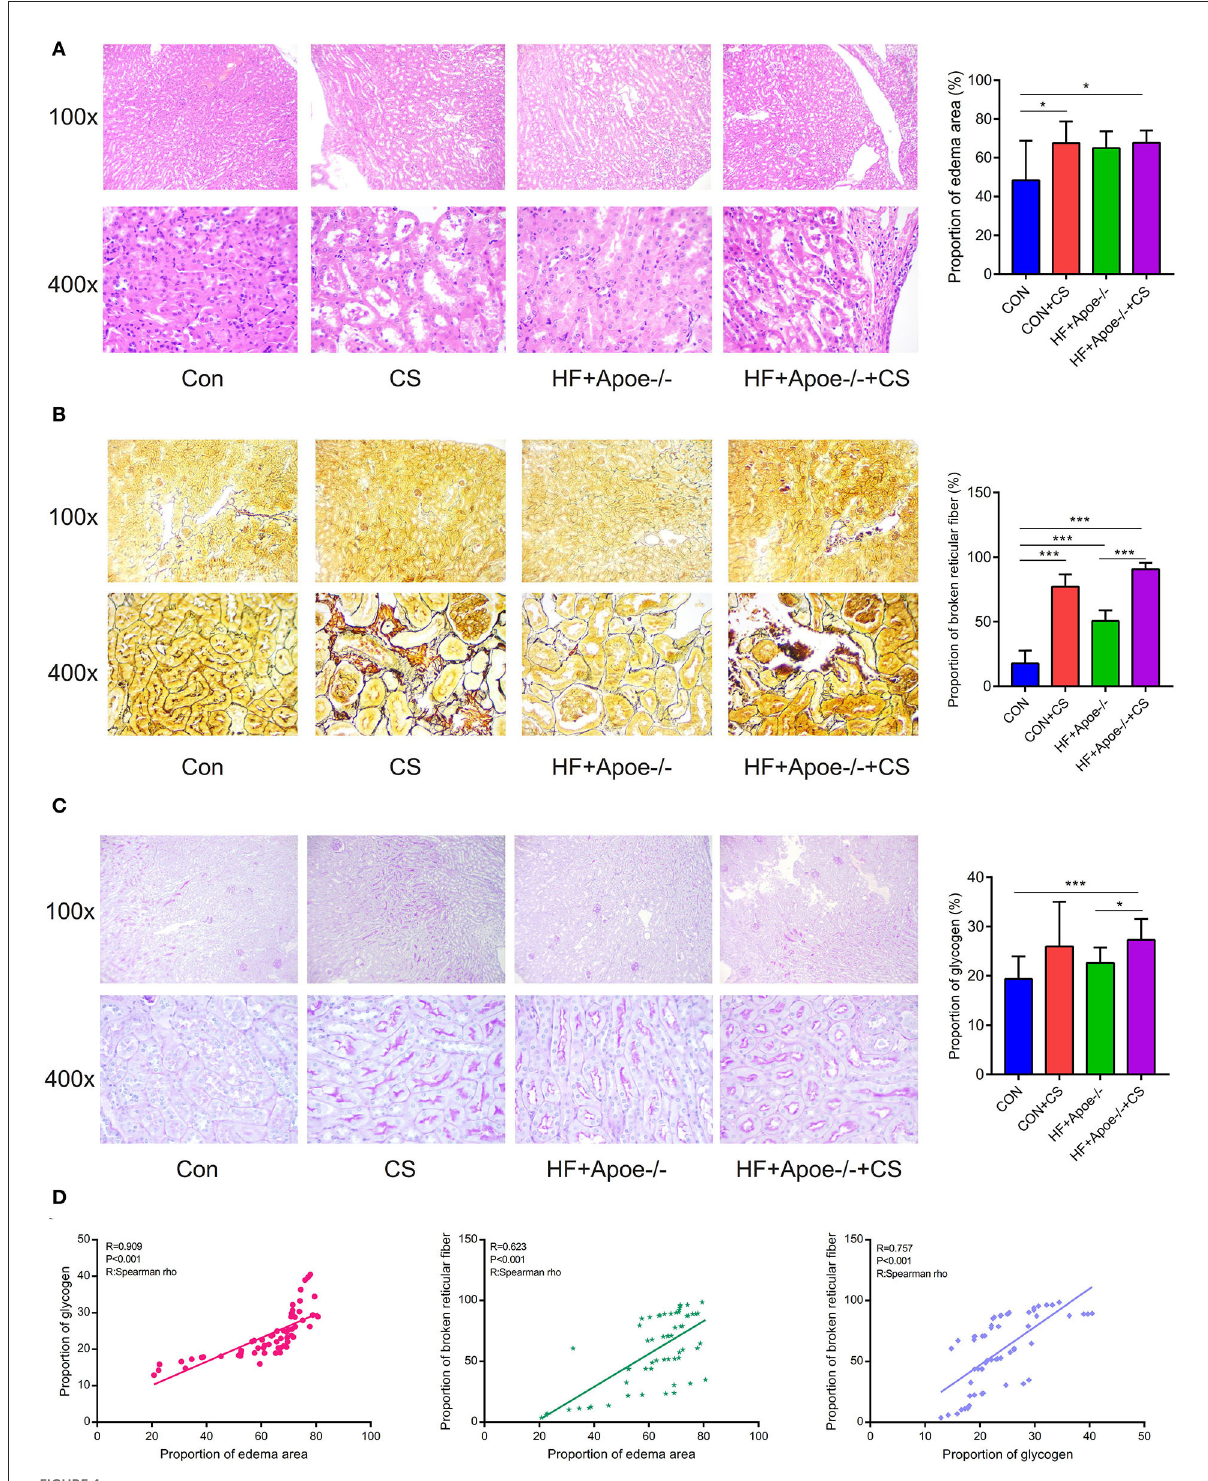
FIGURE4 Edema, broken reticular fibers, and increased glycogen in the kidney under in the HF + Apoe − / − + CS group. (A) HE staining manifested that there existed edema in the kidney at different degrees in the CS, HF + Apoe − / − , and HF + Apoe − / − + CS groups. (B) In the CS, HF + Apoe − / − , and HF + Apoe − / − + CS groups, the reticular fibers in the kidney were destructed and broken. (C) Compared with the CON group, the proportion of glycogen in the HF + Apoe − / − + CS group was significantly higher than that in the CON group. (D) Strongly positive relationships between the proportion of glycogen, broken reticular fiber, and edema area in the kidney. * P < 0.05; *** P <